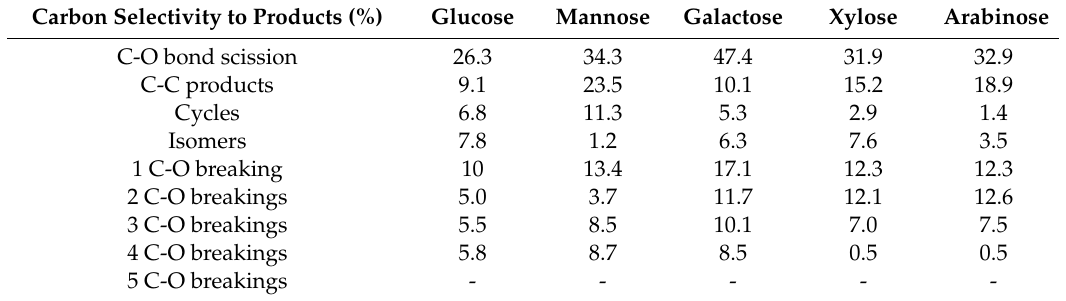
Table 1. Hydrogenolysis of C6 and C5 monosaccharides. Data at 20% of the corresponding polyol remaining. Carbon Selectivity to Products (%) Glucose Mannose Galactose Xylose Arabinose C-O bond scission